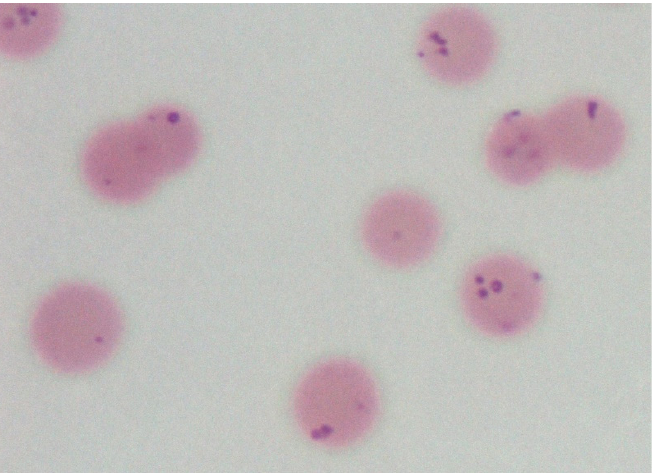
Figure 2 . Image from an ovine blood smear smear containing erythrocytes parasitised by basophilic bodies, consistent with the morphology of M. ovis.